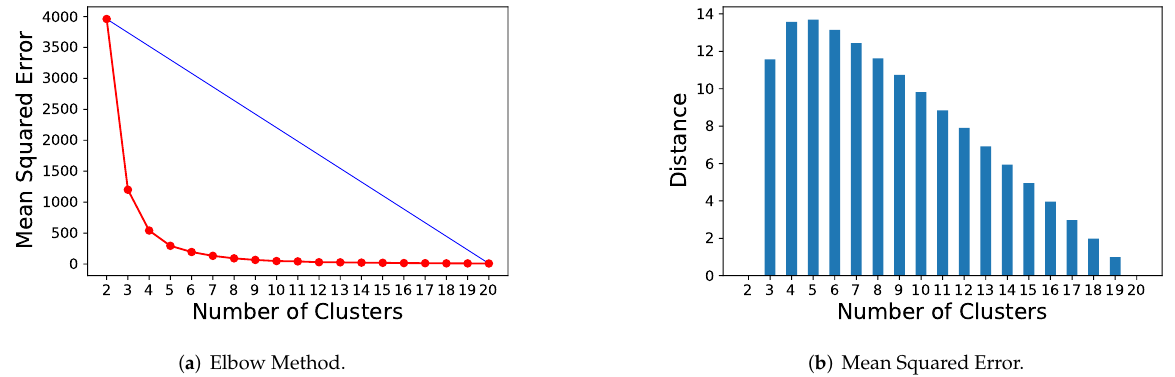
Figure 5. Representation of the number of clusters that best represents the data set. ( a ) The Elbow method searches for the number of clusters, red curve, that is furthest from the support line in blue. ( b ) Mean square error between the samples and the centroid in each configuration with different number of